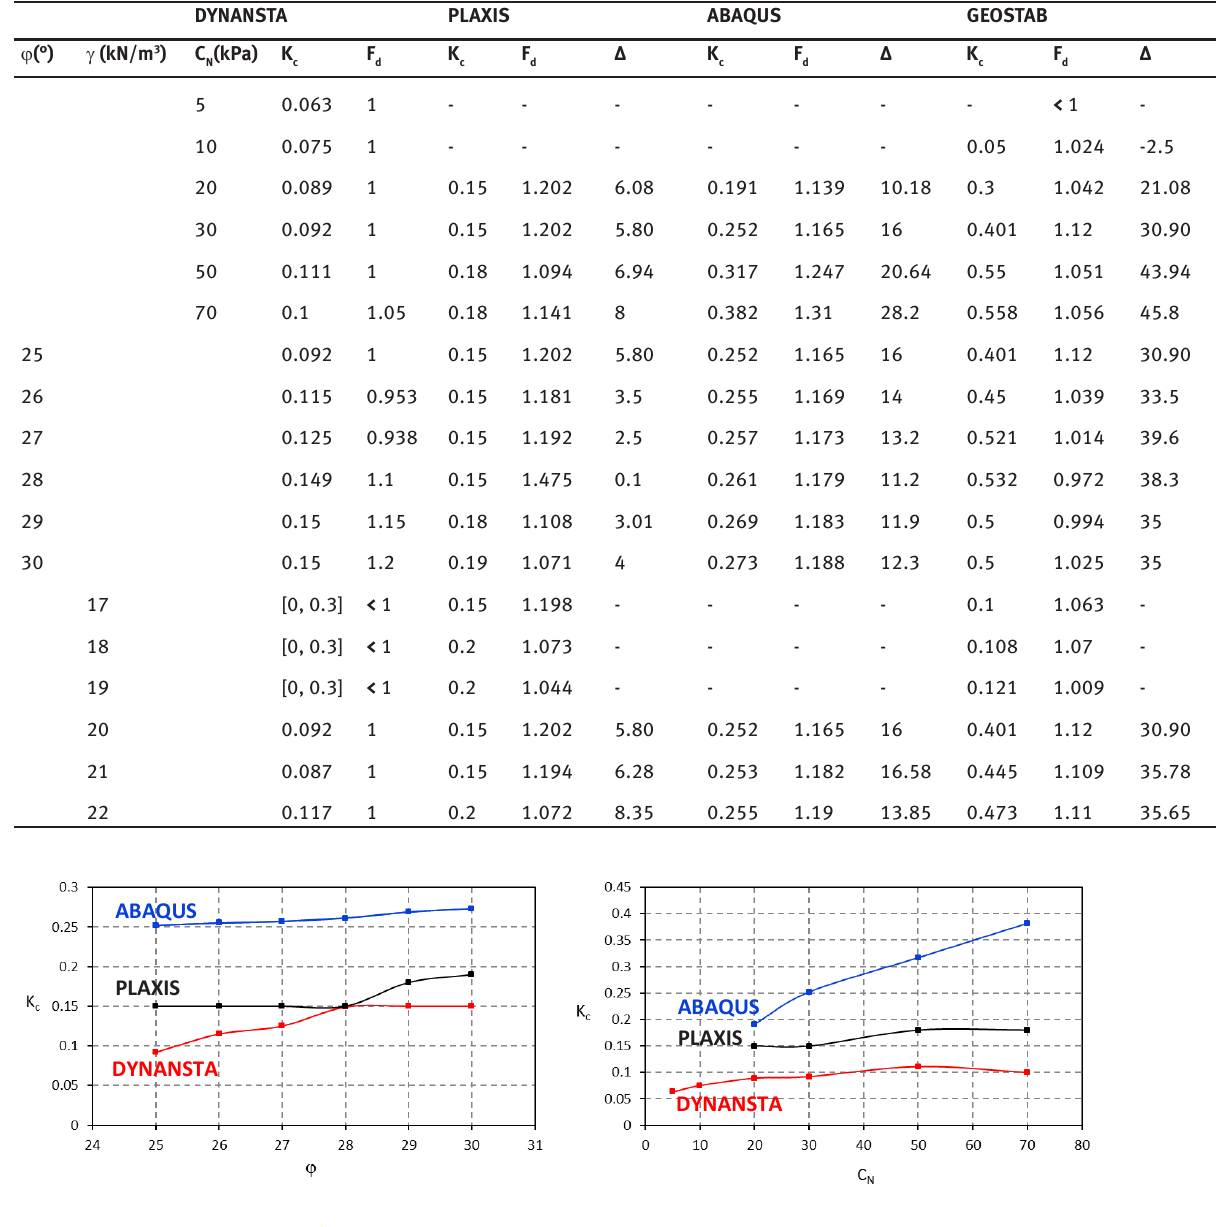
at critical state of the different methods. Table 2: Comparison of K c DYNANSTA PLAXIS ABAQUS GEOSTAB